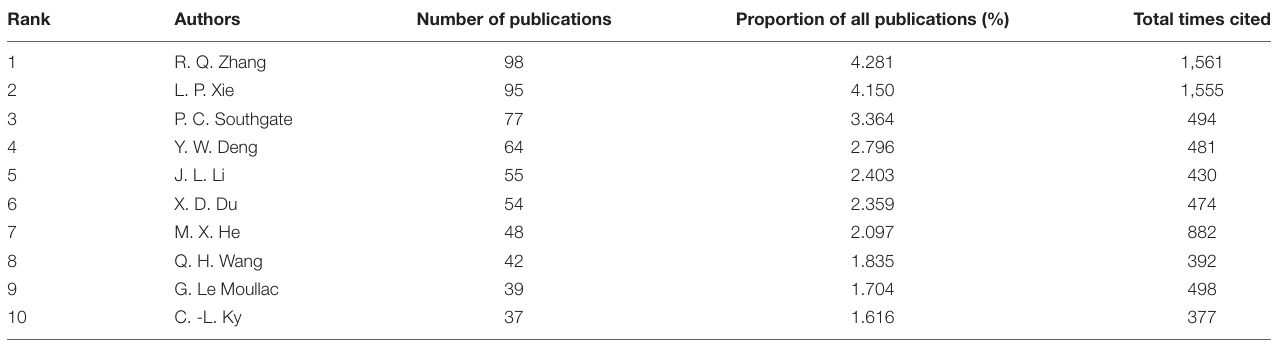
FIGURE 4 | Bibliometric map of the studies of pearl bivalve mollusks as the theme. The size of the dot is proportional to the frequency that an organization appears in the analyzed articles. A line between two dots means that these two organizations appeared in the same article. The positive correlation between the thicker line and the higher frequency indicated that the two organizations appeared continually in the same articles. The color stands for the year when an organization most frequently occurred in articles. TABLE 4 | Among the studies related with pearl bivalve mollusks as the theme, the numbers of publications, the proportion of all publications, and the total times cited for the top 10 authors ranked by the number of publications based on WOS. Number of publications Proportion of all publications